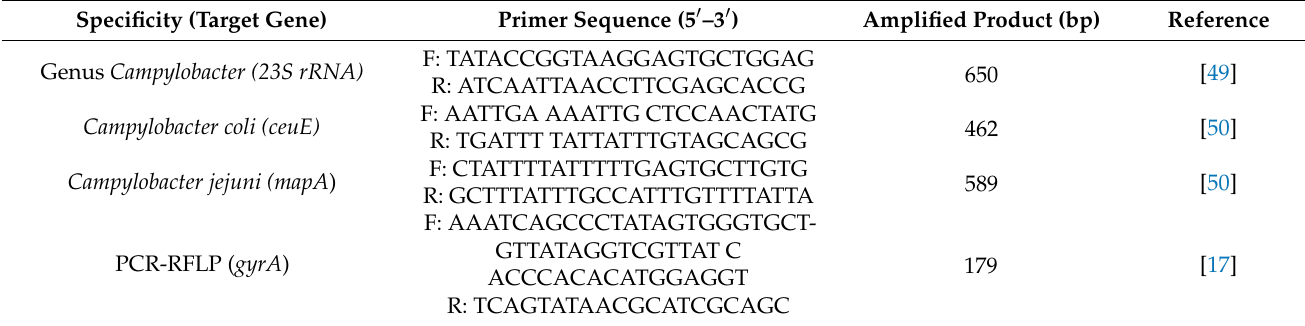
Table 5. Sequences of oligonucleotide primers targeting four genes of Campylobacter species and their PCR-amplified products. Specificity (Target Gene) Primer Sequence (5 (cid:48) –3 (cid:48) ) Amplified Product (bp)